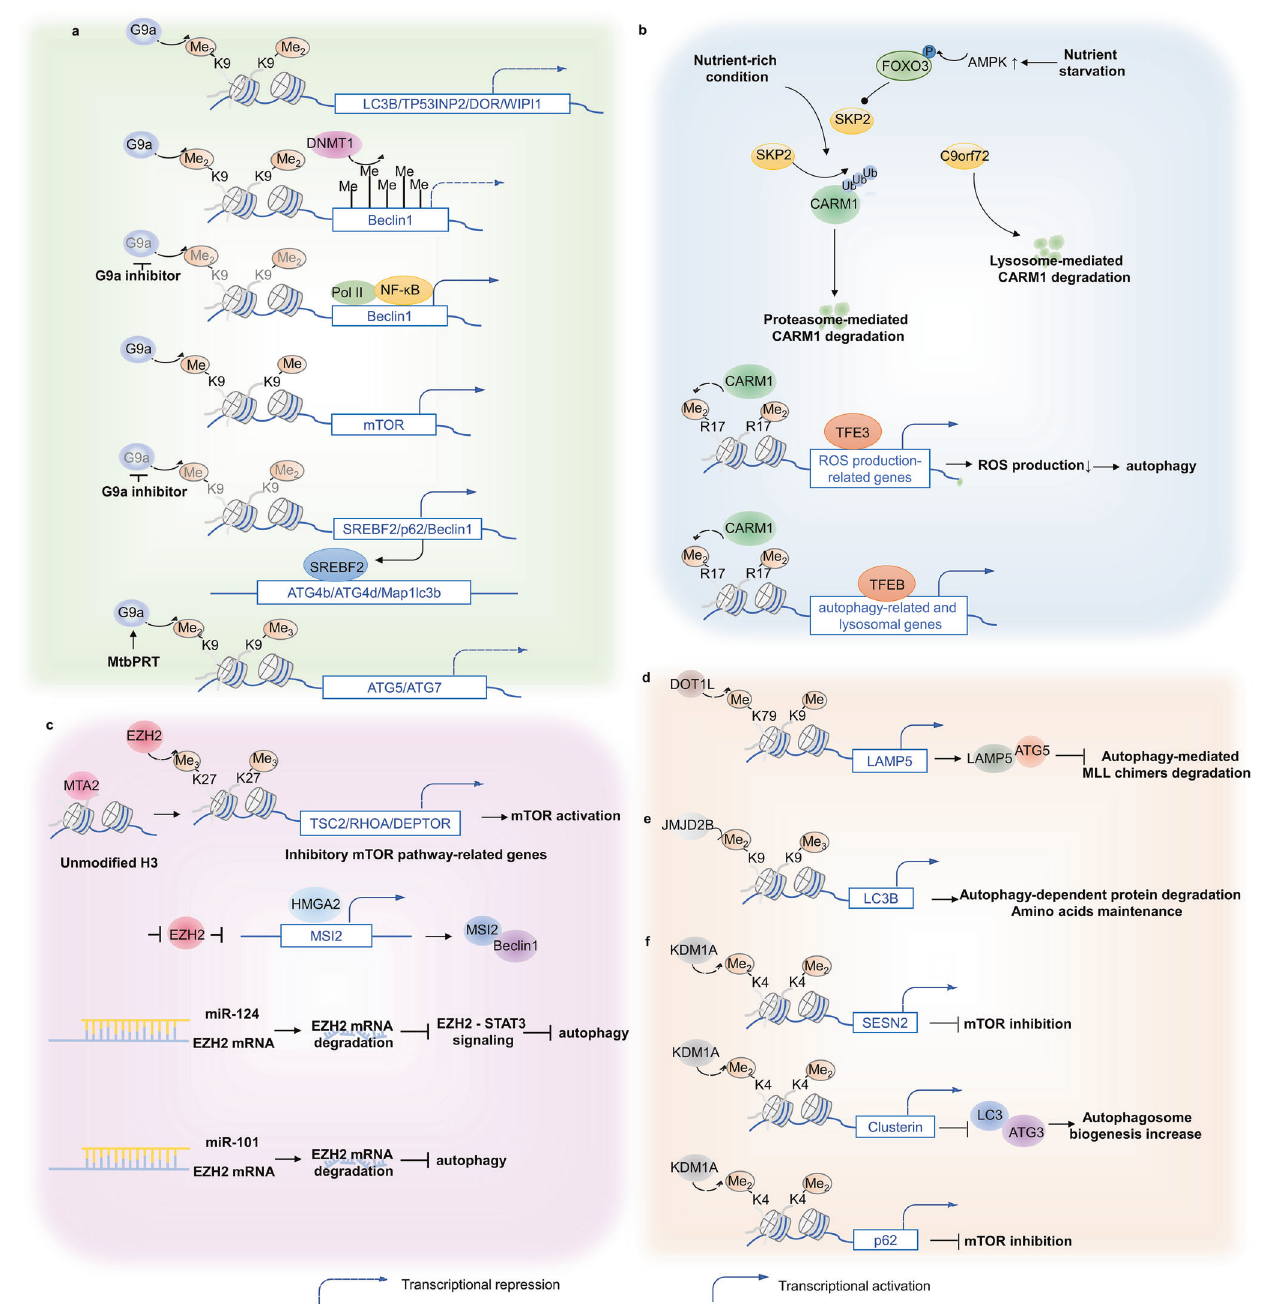
Fig. 2 Histone methylation and autophagy regulation. a G9a negatively regulates core autophagy effectors and upstream autophagic regulators to in fl uence autophagy level indirectly. b Under a nutrient-rich environment, SKP2 mediates CARM1 protein degradation, nutrient starvation activates AMPK-dependent FOXO3 phosphorylation, which transcriptionally represses SKP2, resulting in CARM1-mediated transcriptional activation of autophagy-related and lysosomal genes. c EZH2 repressively regulates autophagy via mTOR activation. EZH2 negatively controls TSC2/RHOA/DEPTOR gene transcription to elicit mTOR pathway, leading to autophagy inhibition. Additionally, EZH2 represses HMGA2 expression. HMGA2 can directly activate the MSI2 promoter region, which triggers autophagy via Beclin1 interactions. d DOT1L elevates LAMP5 expression via H3K79 methylation modi fi cation enhancements. LAMP5 directly interacts with ATG5 to interrupt an autophagy fl ux, protecting MLL chimeras from autophagy degradation. e JMJD2B promotes autophagy occurrence via histone demethylation at LC3B promoters, assisting in intracellular amino acid maintenance. f KDM1A negatively manipulates autophagy fl ux through SESN2- and CLU-dependent pathways or directly targeting p62. SESN2 inhibits mTORC1 activity, and CLU increases autophagosome biogenesis through MAP1LC3/LC3-ATG3 heterodimer clusterin (CLU) transcription, which is an integral part of the as for ovarian aging, LSD1 represses autophagy level by affecting autophagic process as it increases autophagosome biogenesis by H3K4me2 level and regulating the transcription of p62 to protect stabilizing the MAP1LC3/LC3-ATG3 heterodimer. 85,86 In addition, oocytes against preterm death 87 (Fig. 2f).